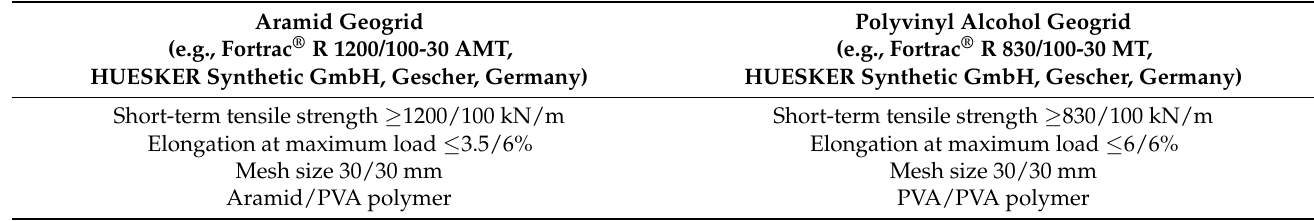
Table 1. List of exemplary parameters of the applied geosynthetics.